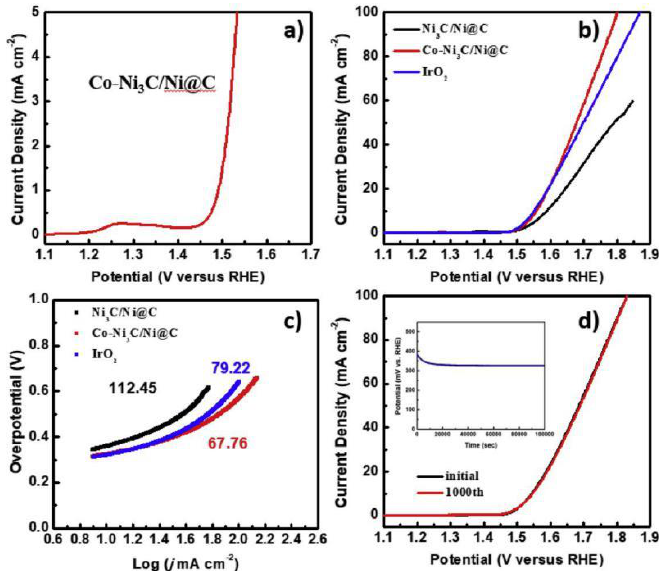
Figure 4. ( a ) OER polarization curves tested in 1.0 M KOH of Co-Ni 3 C / Ni@C. ( b ) OER polarization curves tested in 1.0 M KOH of Co-Ni 3 C / Ni@C, Ni 3 C / Ni@C and IrO 2 . ( c ) Tafel plots of di ff erent samples. ( d ) Polarization curves of Co-Ni 3 C / Ni@C before and after 1000 cycles, and the chronoamperometric response at a constant current of 10 mA / cm 2 of Co-Ni 3 C / Ni@C. Reproduced with permission from [64]. Copyright 2019 International Journal of Hydrogen Energy .